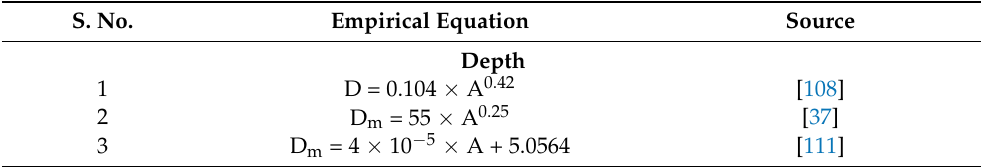
Table 2. The empirical equations derived from the literature: (a) depth, (b) volume, and (c) peak discharge. S.